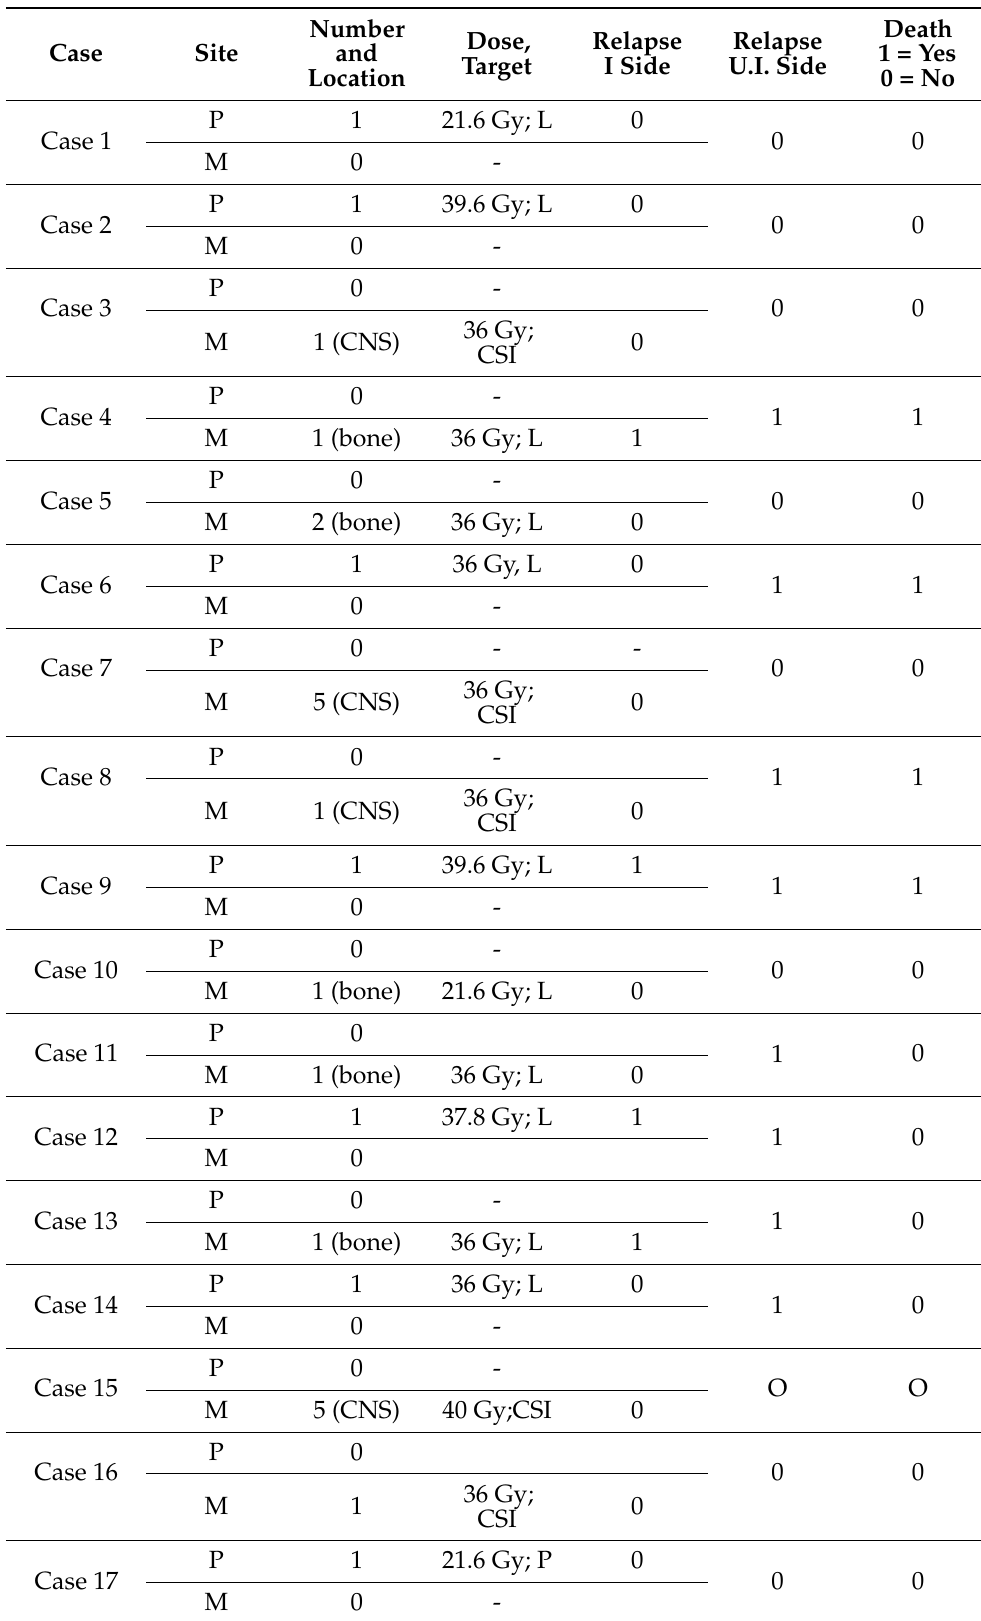
Table 2. Overview of the applied